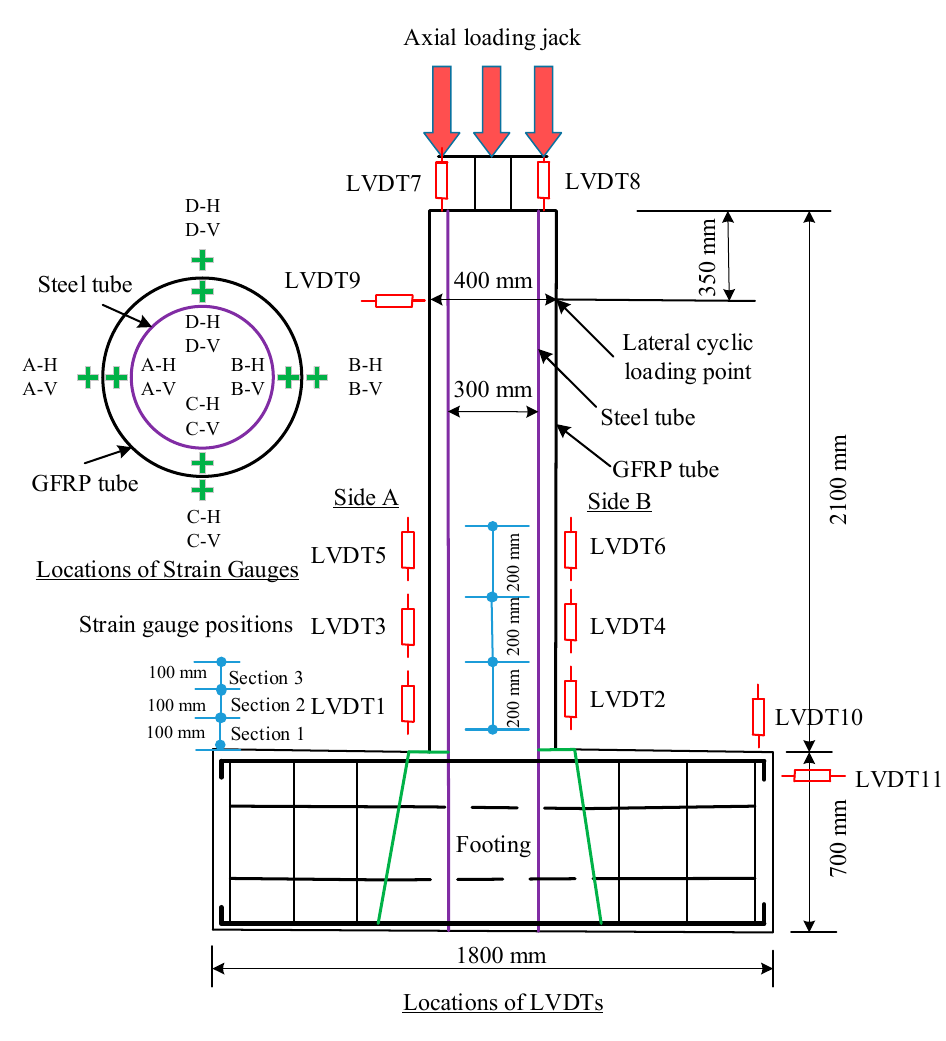
Figure 4. Instrumentation for LVDTs and strain gauge arrangement.